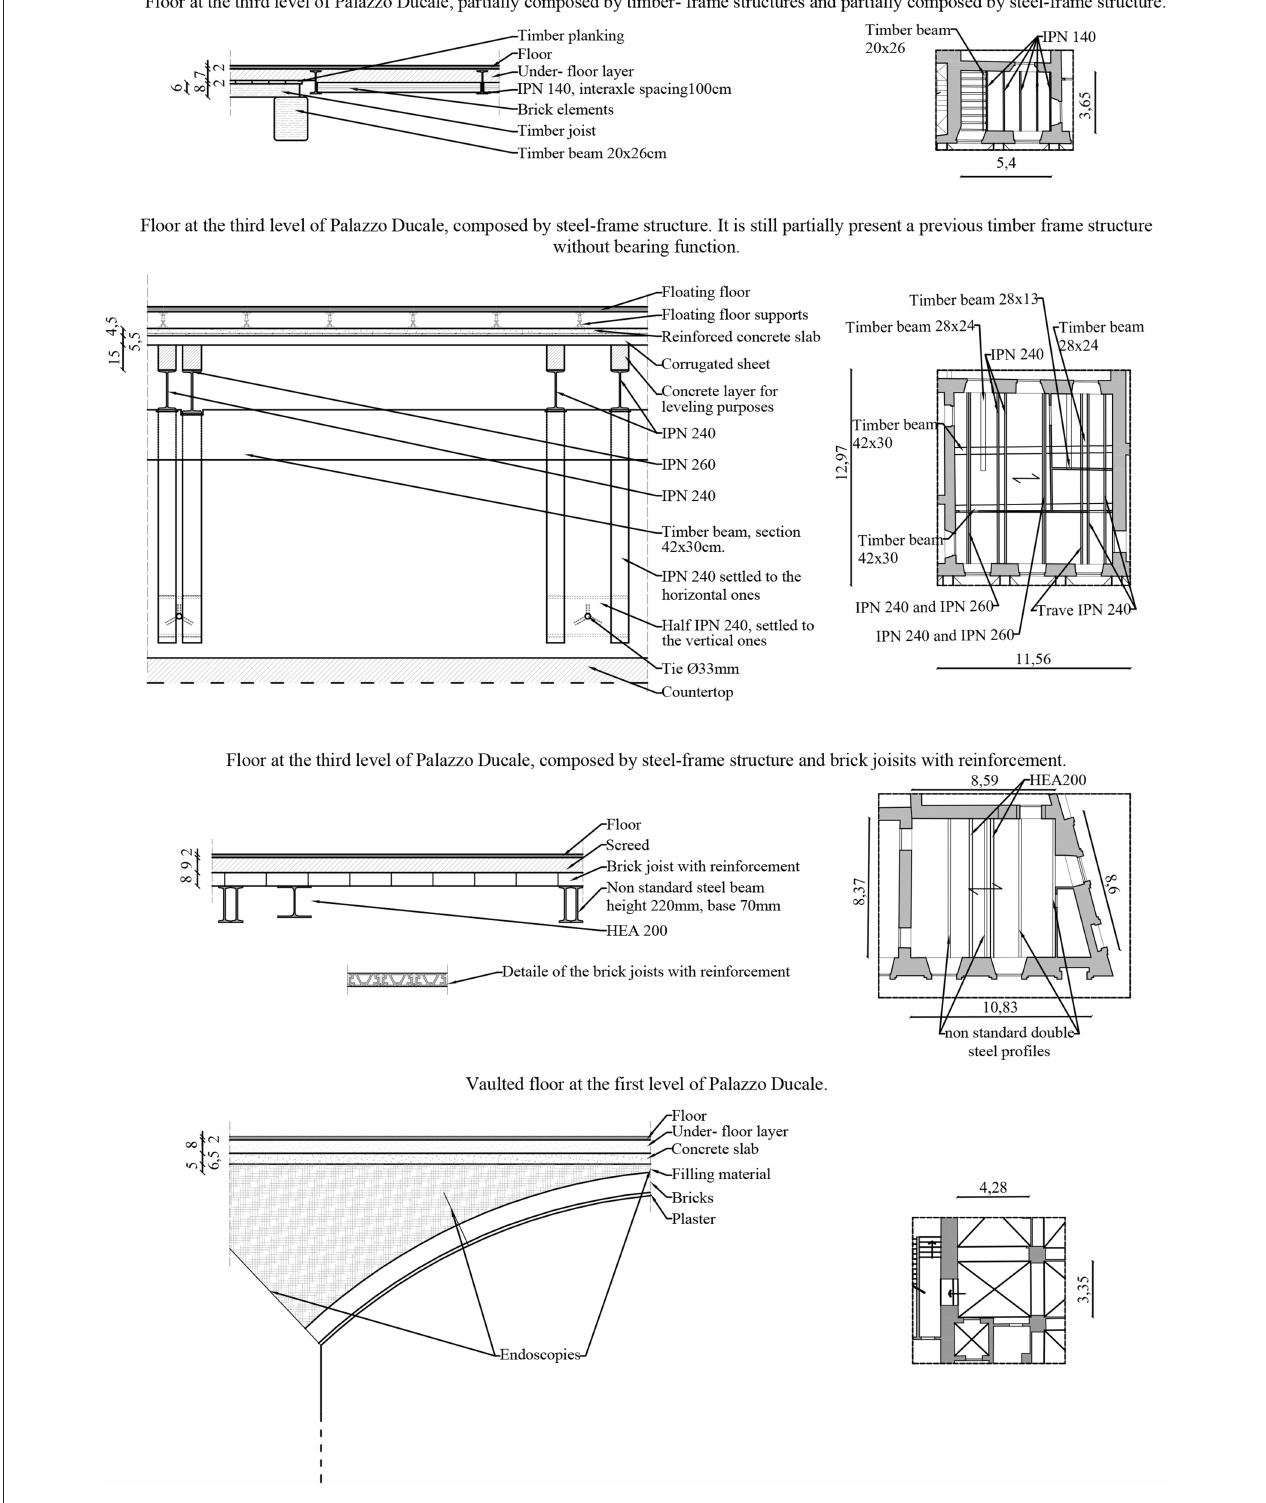
FIGURE 12 | Examples of structural details surveyed in Palazzo Ducale.